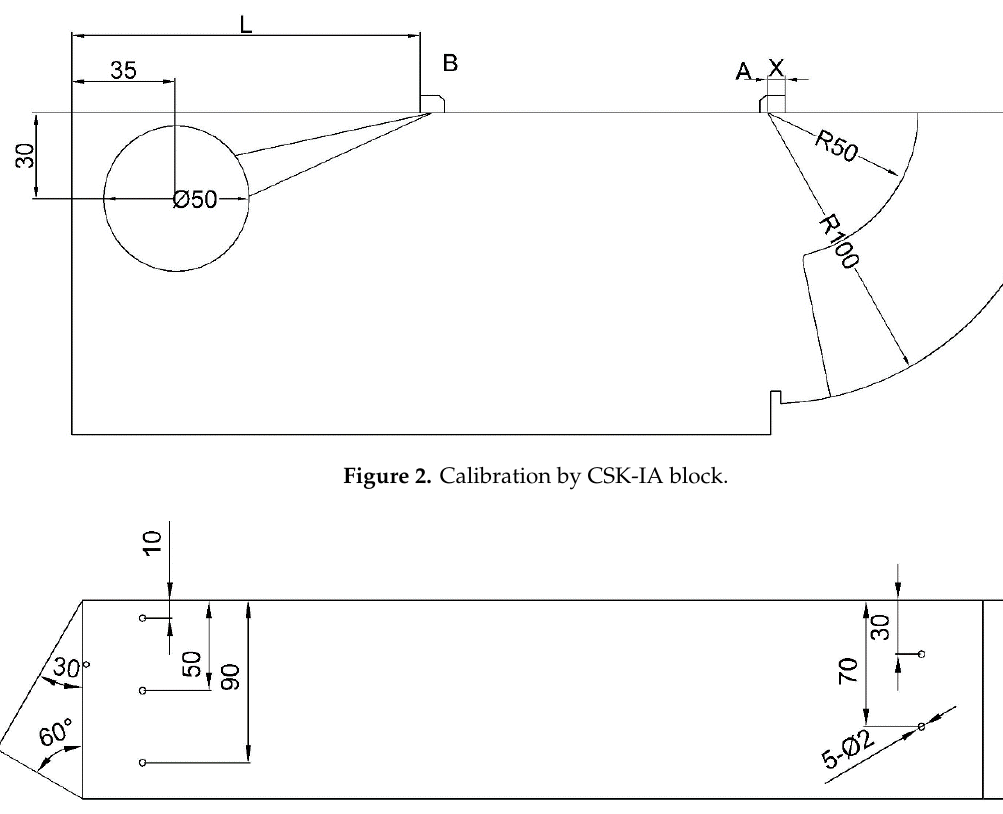
Figure 3. Calibration by CSK-IIA-2 block.